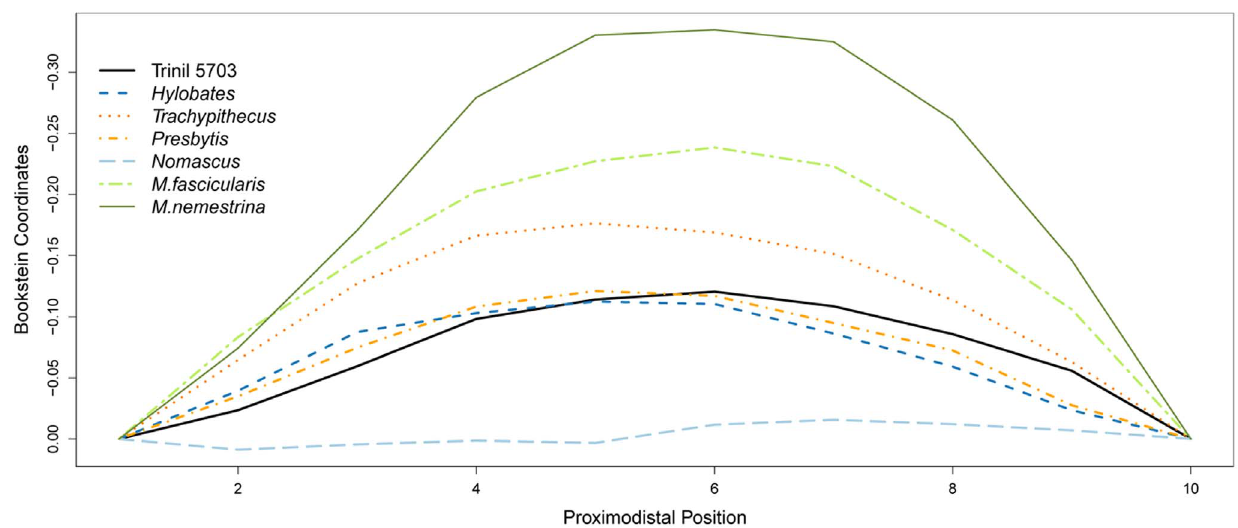
Figure 6. Comparison of Trinil 5703 femoral curvature with other primates through Bookstein baseline regression of ten evenly- space horizontal landmarks on the mid-sagittal plane over the shaft with the first and second points adjacent to the line just below the lesser trochanter and half of the shaft length respectively.